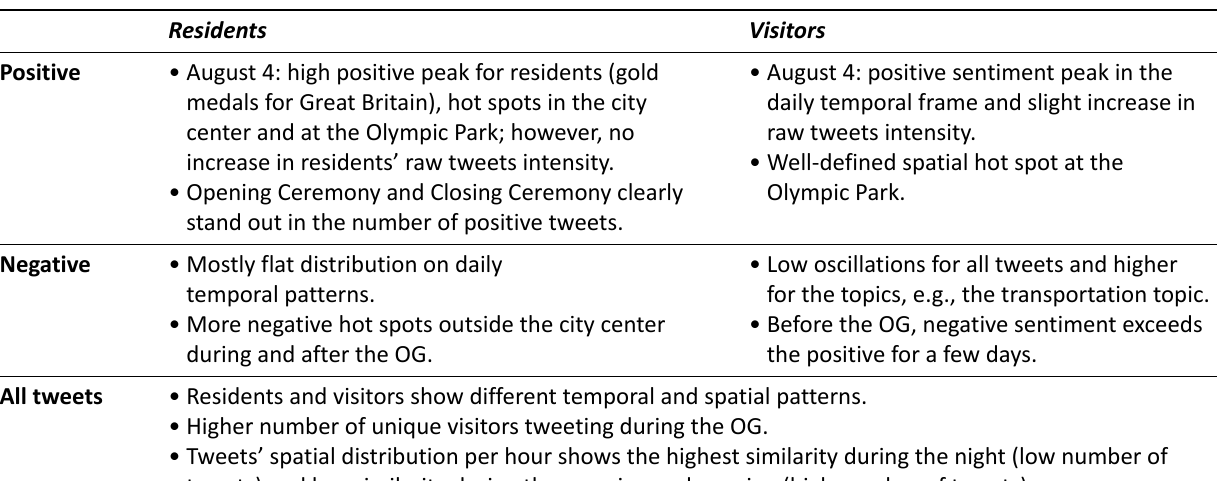
Table 1. Results